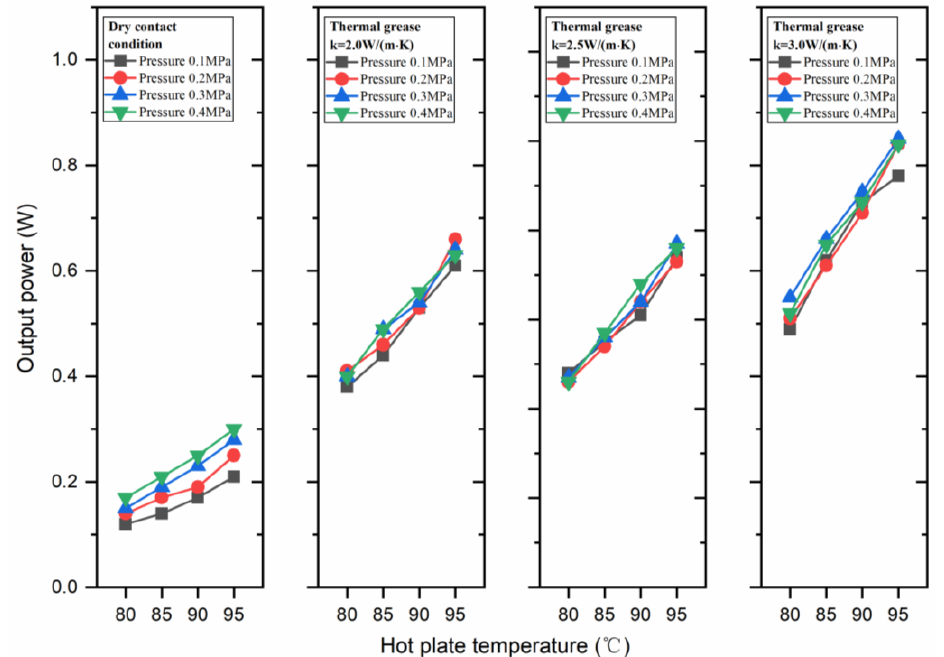
Figure 9. The output power varies with the external loads at di ff erent temperatures of hot plate and thermal interface materials.